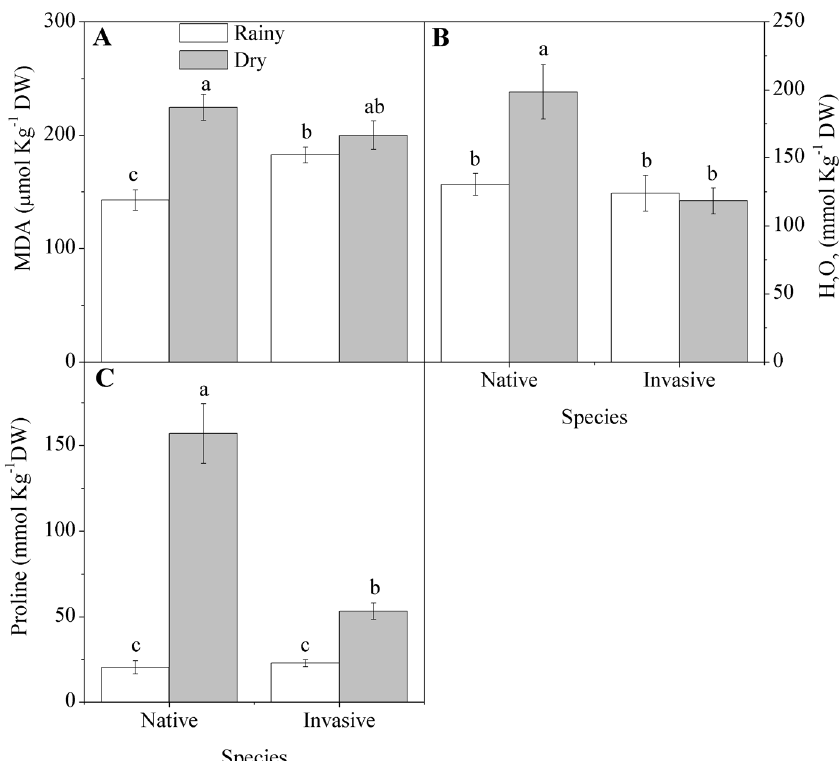
Figure 6. Evidence of stress in native ( Anadenantheracolubrina) and invasive ( Prosopisjuliflora ) species in a tropical dry forest in Brazil across seasons: (A) Malondialdehyde (MDA); (B) hydrogen peroxide (H 2 O 2 ), (C) proline. Values represent the average of replicates (n=20 6 SE; invasive dry season n=25 6 SE). Different letters denote statistical differences by Newman-Keul test with significance level of 5 percent between variables.